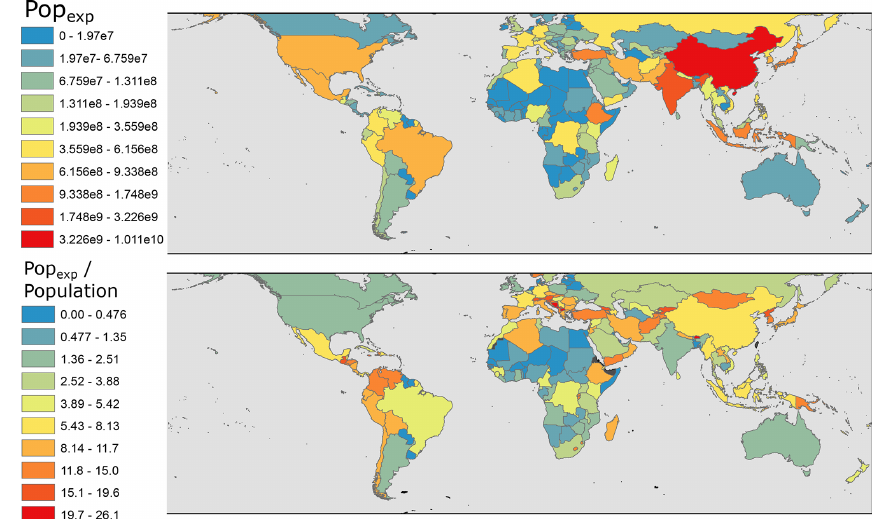
Figure 3. Above: country-wide estimates of population exposure (Pop exp ). Below: population exposure normalised by total population. This is expressed as Pop exp divided by total 2018 population derived from the World Bank data archives (World Bank, 2018). Countries in black in lower figure lack World Bank population estimates.